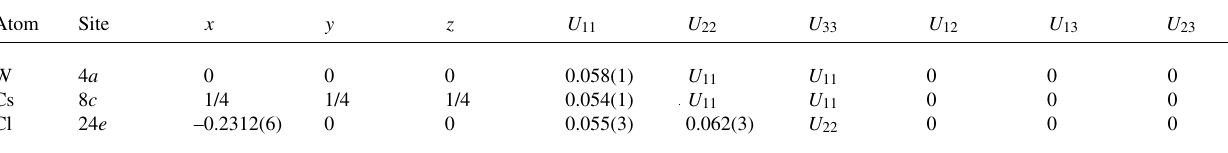
Table 2. Atomic coordinates and displacement parameters (in Å 2 ) .